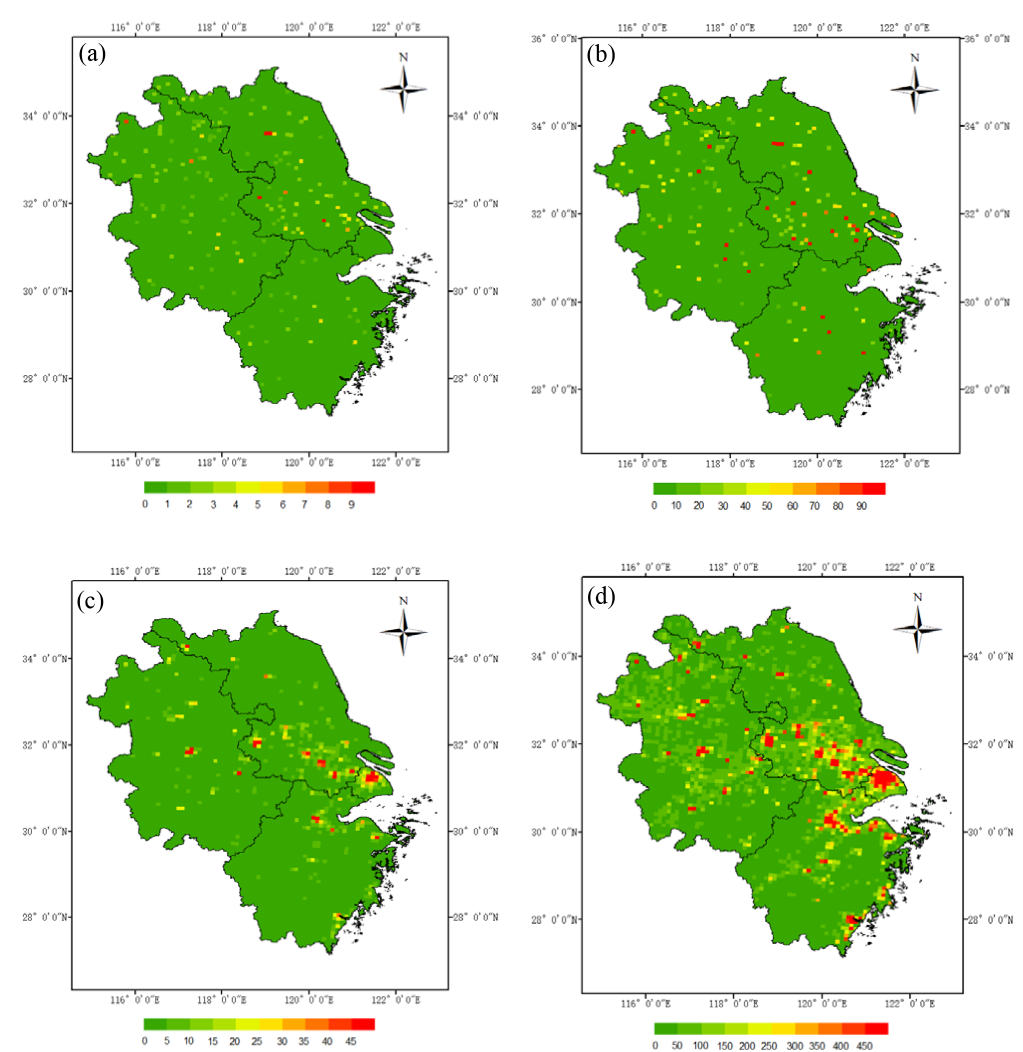
Figure 9. The spatial distributions of the avoided deaths and YLL attributable to the reduced PM 2 . 5 exposure with ultra-low emission policy implementation at a horizontal resolution of 9km. Note the different color ranges in the panels for easier